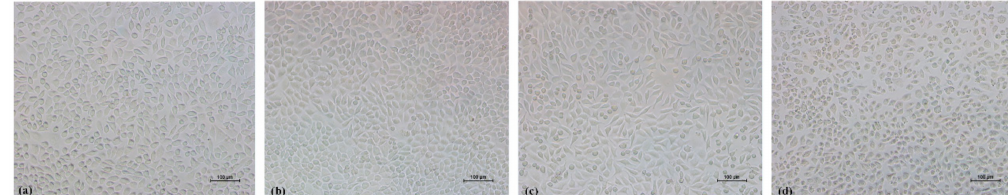
Figure 8. Morphology of cells in ( a ) the blank group, ( b ) the negative group, ( c ) 100% extract, and ( d ) the positive